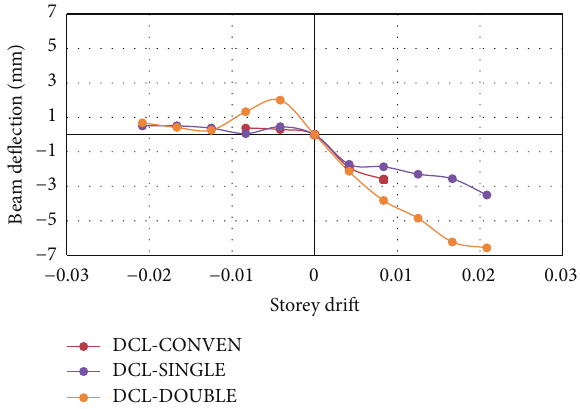
Figure 18: The drift versus beam deflection curves for both loading directions, positive and negative for the DCL group.